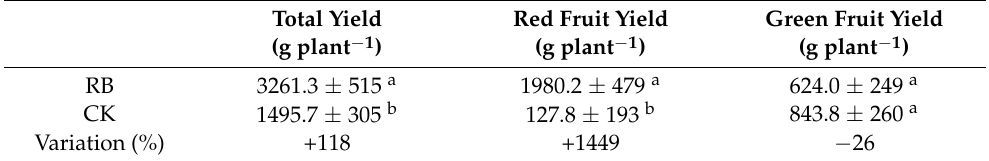
Table 4. Effect of supplemental red and blue LED light (RB) and natural light only (CK) on tomato yield. Different letters indicate significant differences at ANOVA (significant level p ≤ 0.05).